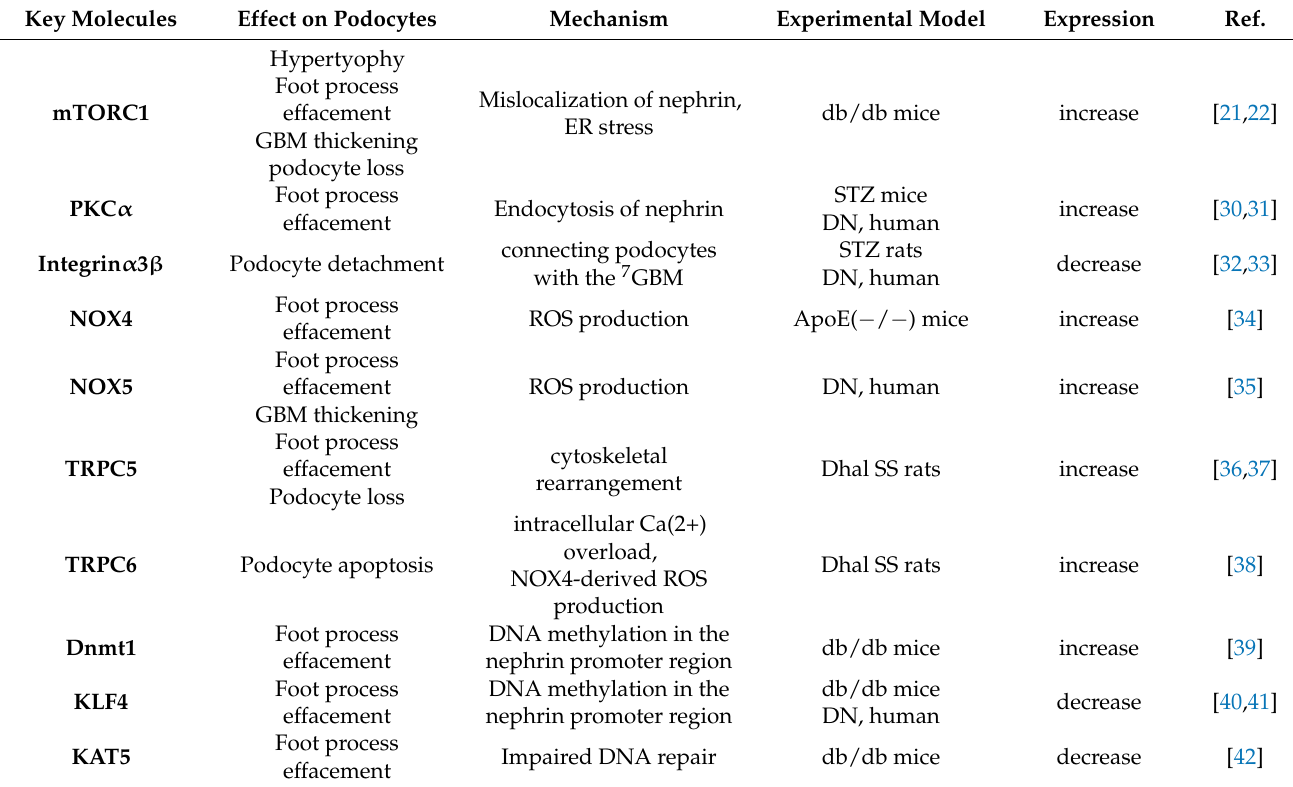
Table 1. Key molecules associated with high glucose in podocytes. Key